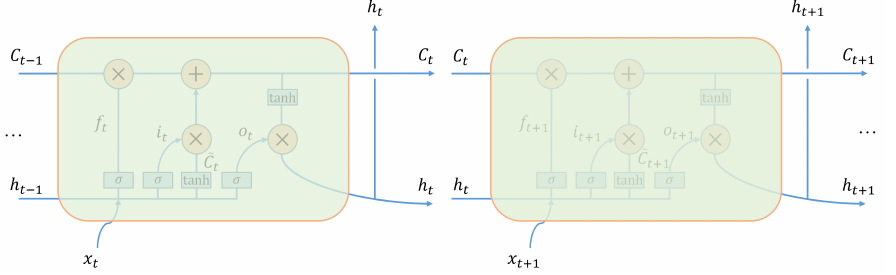
Figure 5. The sequence classification model based on LSTM unit. x t is the input at time step t and h t is the output at time step t